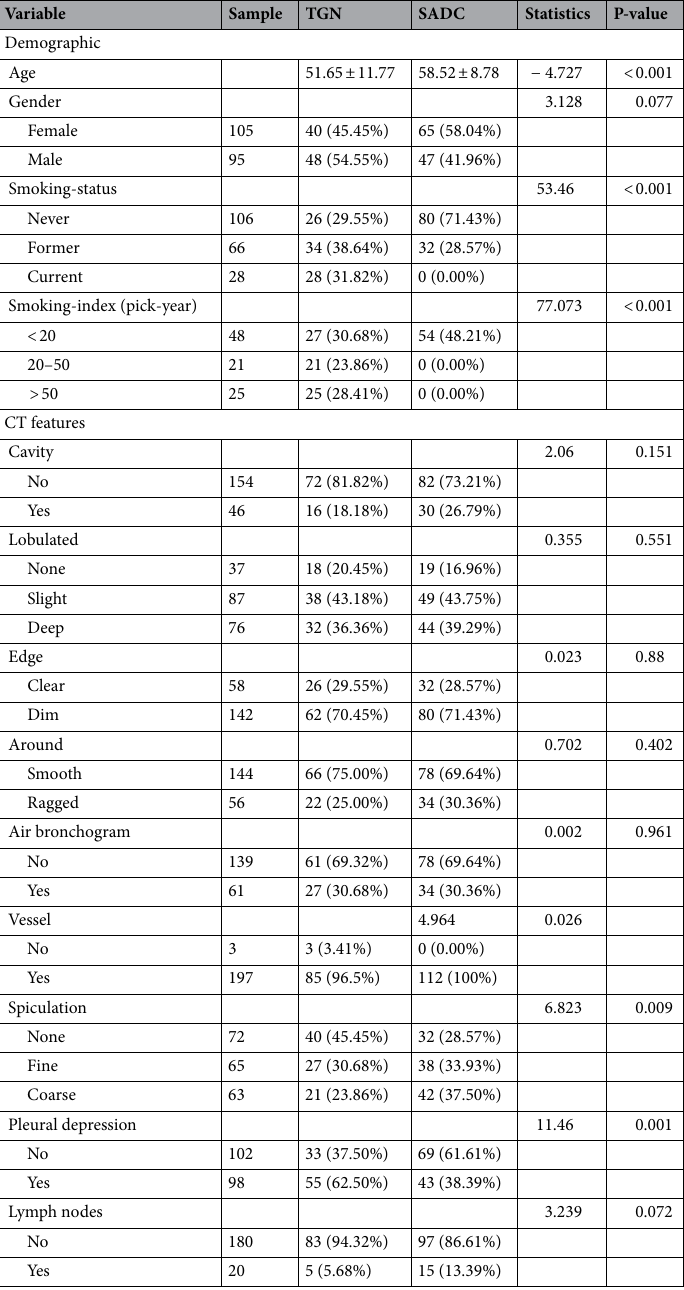
Table 1. Biological features and CT features of all